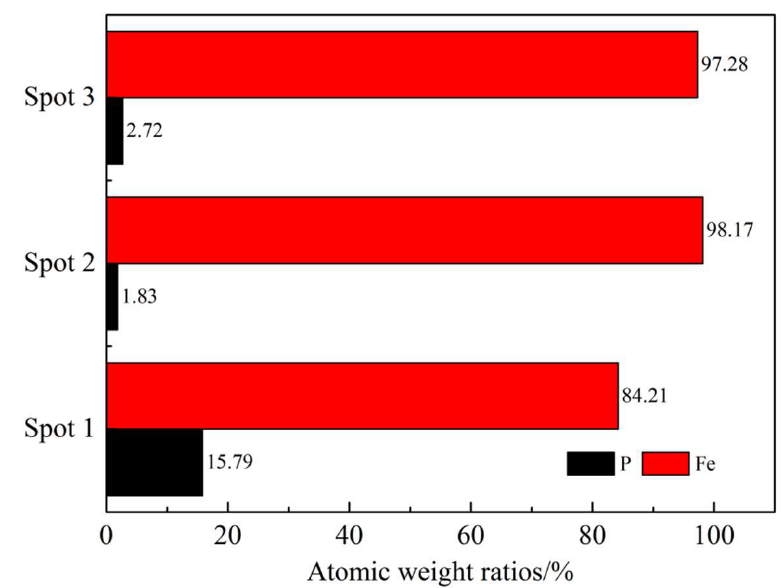
Figure 13. EDS analysis results of spots 1 to 3 in the metal phase.